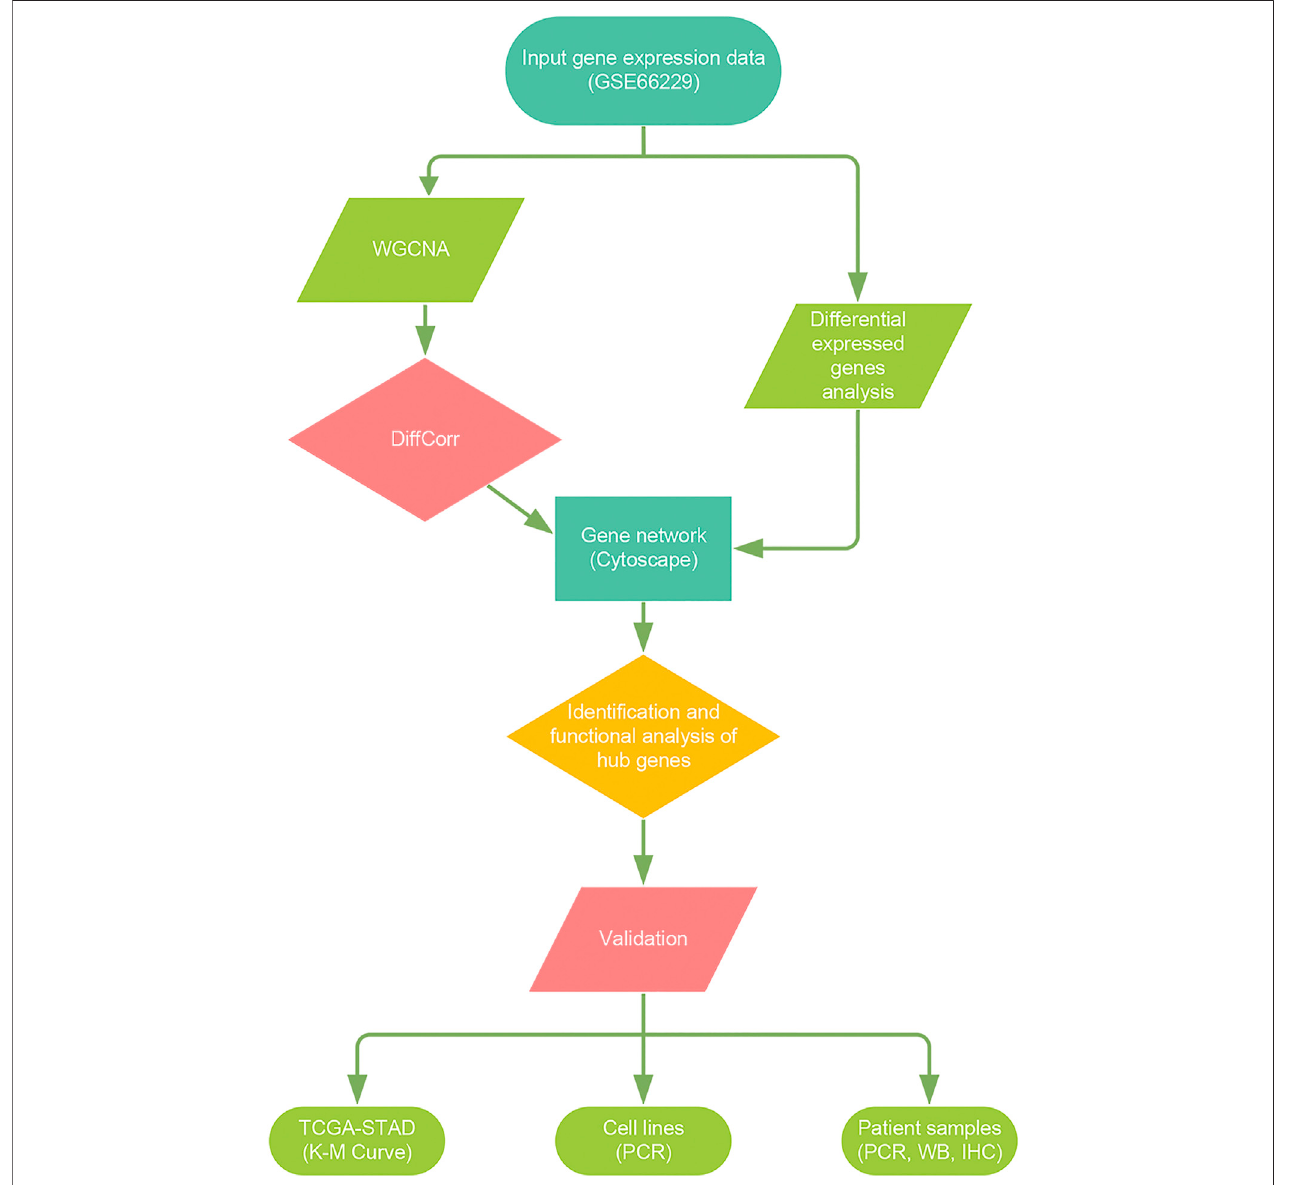
FIGURE 1 | Flow diagram of the study. Data processing, analysis, and validation was shown in the picture.